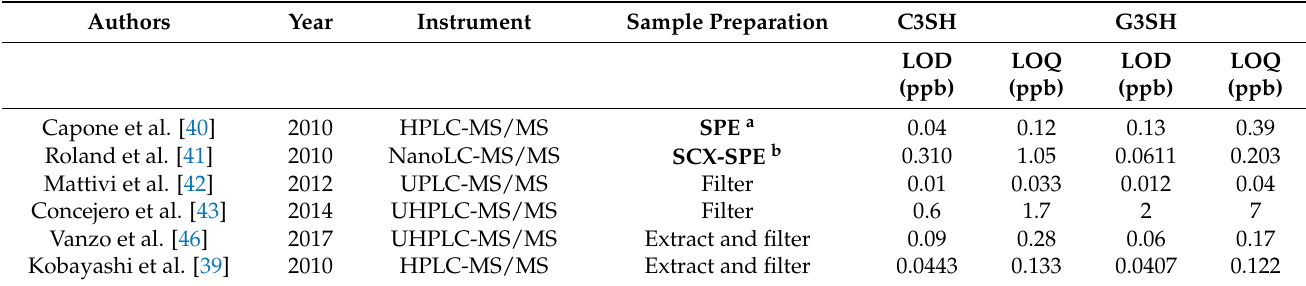
Table 3. Summary of the reported method sensitivities for thiol precursor analytical methods utilizing a range of sample preparation techniques (use of SPE indicated in bold): a Polymeric SPE